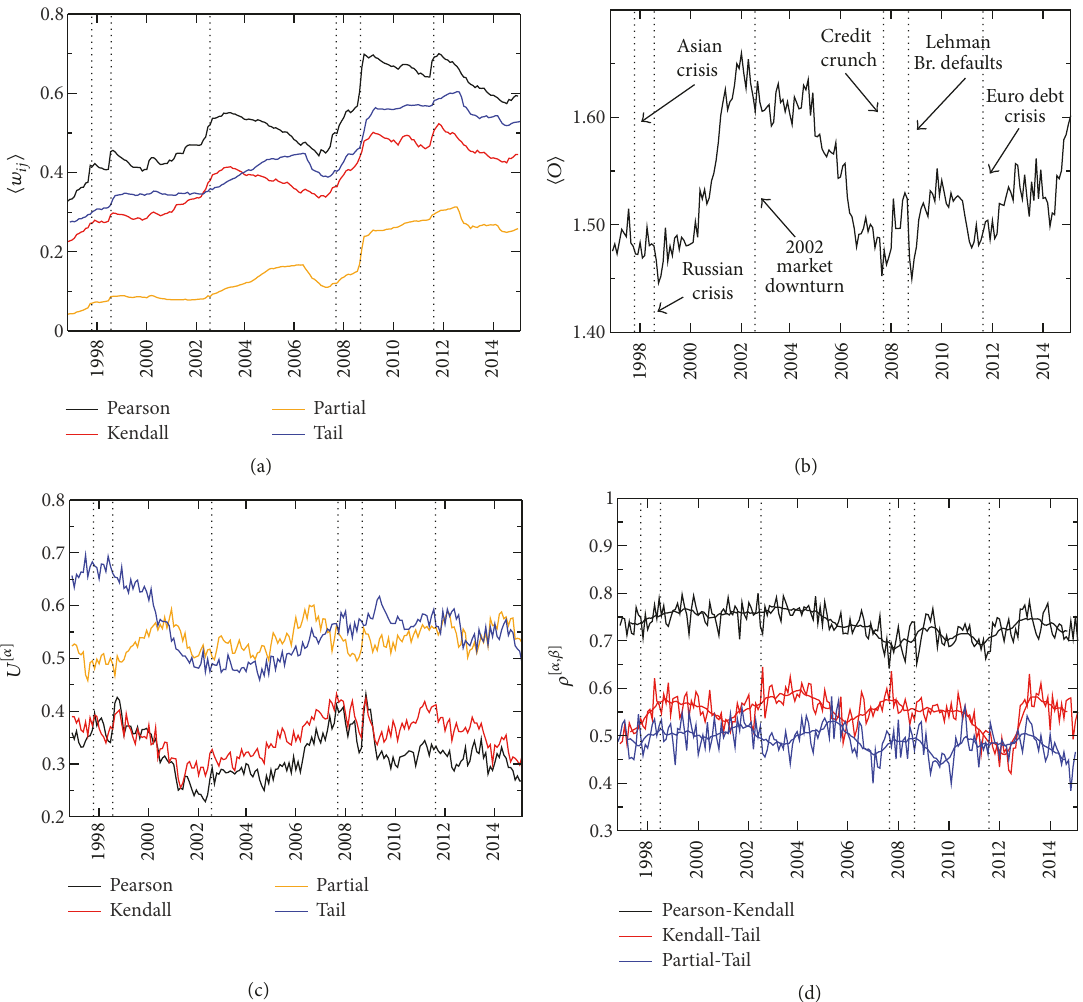
Figure 1: The multiplex nature of dependence among financial assets. The plots report the network analysis of a multiplex whose four layers are Planar Maximally Filtered Graphs (PMFGs) obtained from four classical dependence measures, namely, Pearson, Kendall, Tail, and Partial correlation,computedonrollingtimewindowsof23tradingdaysbetween1993and2015.Eachofthefourlayersprovidesdifferentinformation on the dependency structure of a market. Although market events and trends have a somehow similar effect on the average dependence ⟨𝑤 𝑖𝑗 ⟩ between nodes at the different layers (panel (a)), each layer has a distinct local structure. This is made evident by the plots of the average edge overlap ⟨𝑂⟩ (panel (b)) and of the fraction 𝑈 [𝛼] of edges unique to each layer, which confirm that an edge exists on average on less than two layers, and up to 70 % of the edges of a layer are not present on any other layer. Moreover, the same node can have different degrees across the four layers, as indicated by the relatively low values of the pairwise interlayer degree correlation coefficient 𝜌 [𝛼,𝛽] reported in panel (d) for three pairs of layers over the whole observation